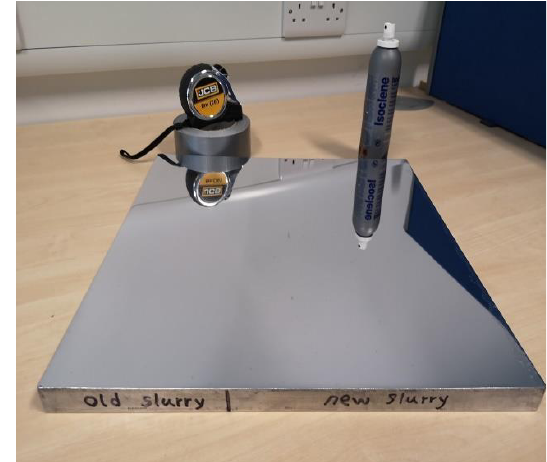
Fig. 6. Processing results with different slurry